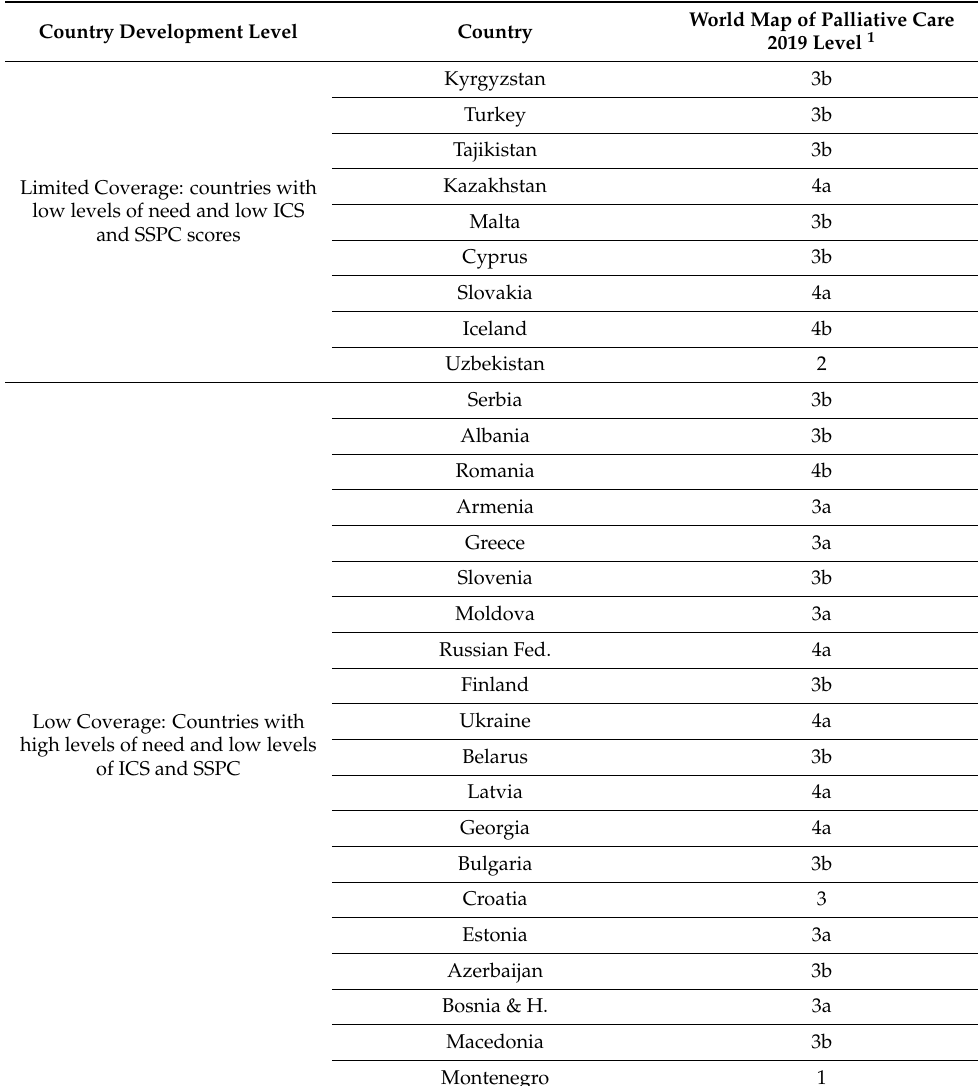
Table 3. Cont . Country Development